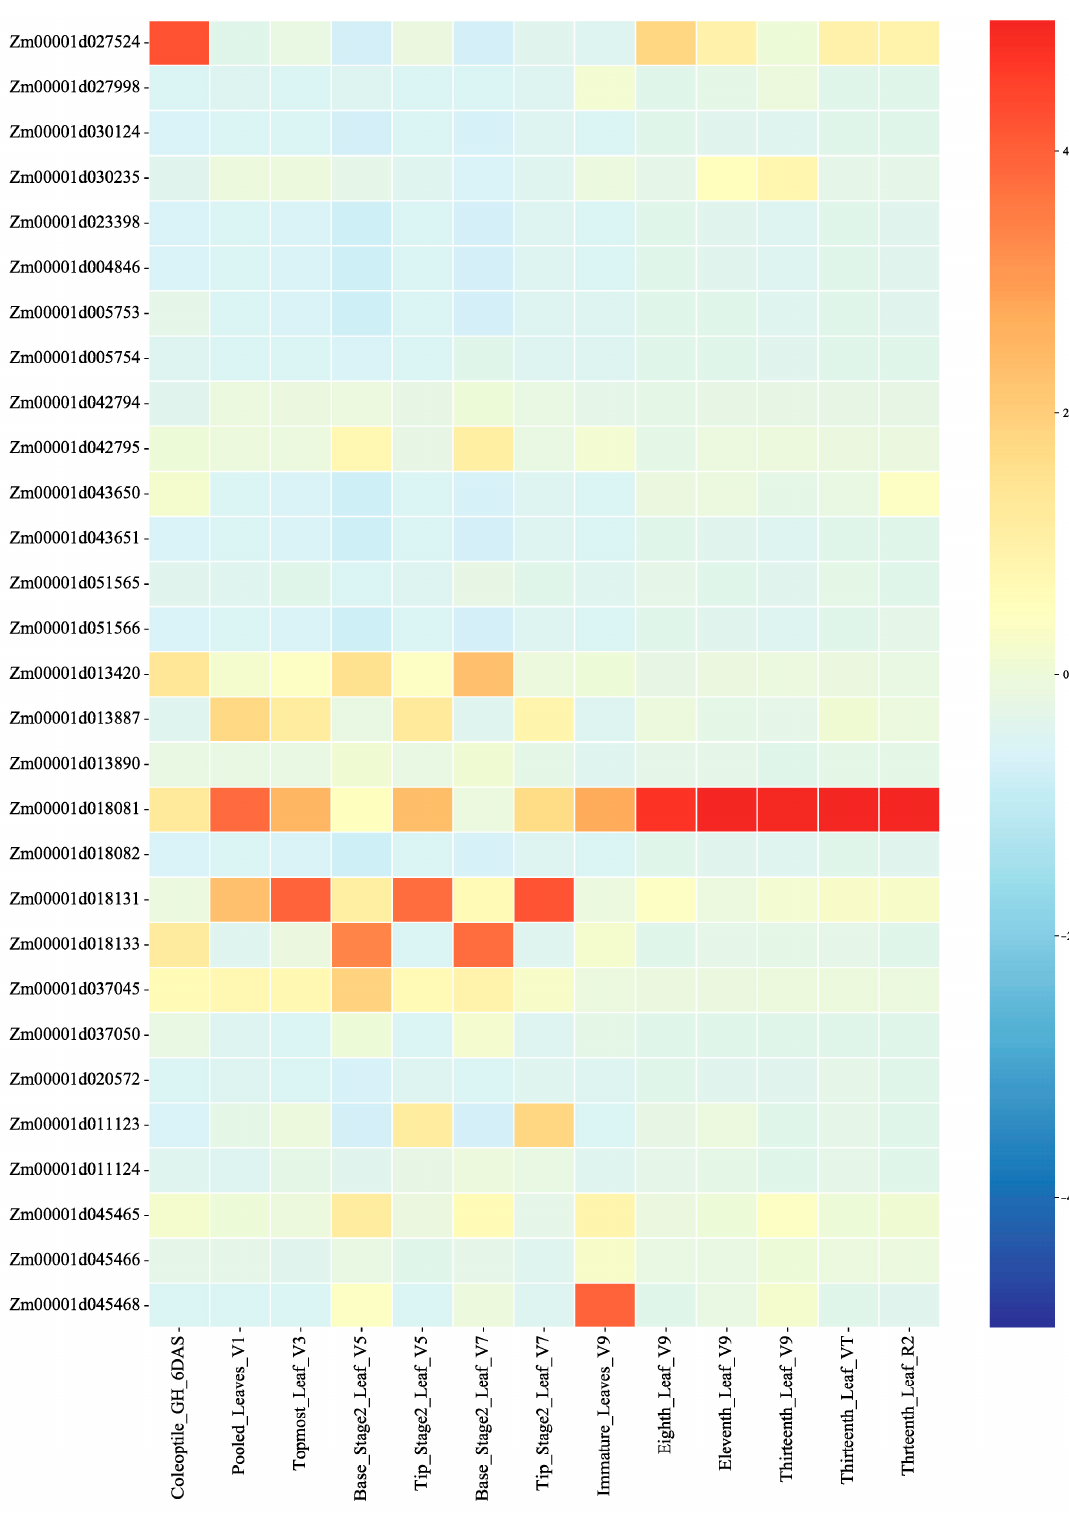
Figure 6. Heatmap of 29 functionally annotated genes’ expression in 13 different development stages of maize leaves. DAS: days after sowing, Vn: vegetative stage corresponding to the number of emerged leaves, VT: vegetative tasseling stage, R2: reproductive stage